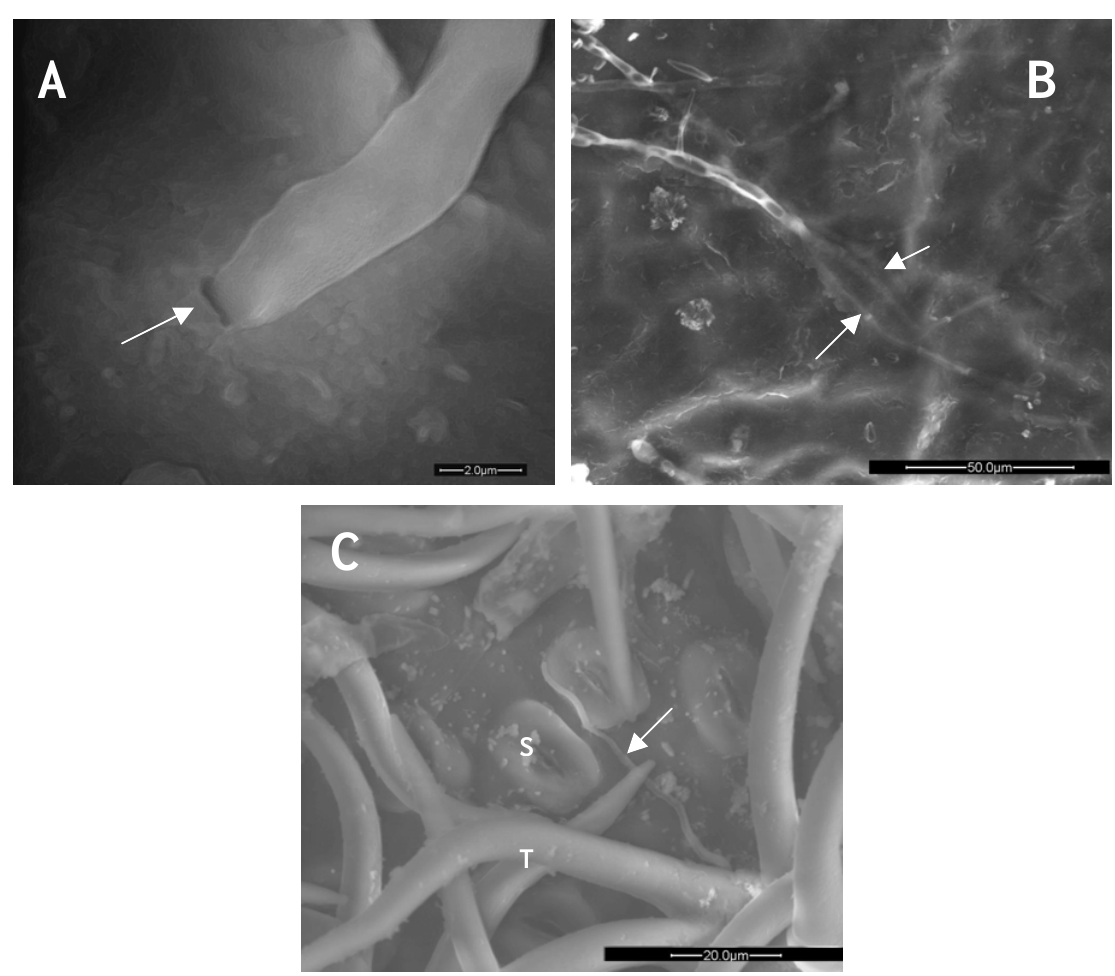
FIGURE 4. Quercus suber leaves sprayed with a suspension of D. corticola conidia. Control leaf: A, penetration through the cuticle by inducing a hollow (arrow) (adaxial blade); B, hyphae embedded into the wax layer (arrows) (adaxial blade). Ozone-exposed leaf (110 ppb O 3 , 5 h day –1 , 30 days): C, development of an hypha (arrow) (S = stoma, T = trichome) (abaxial